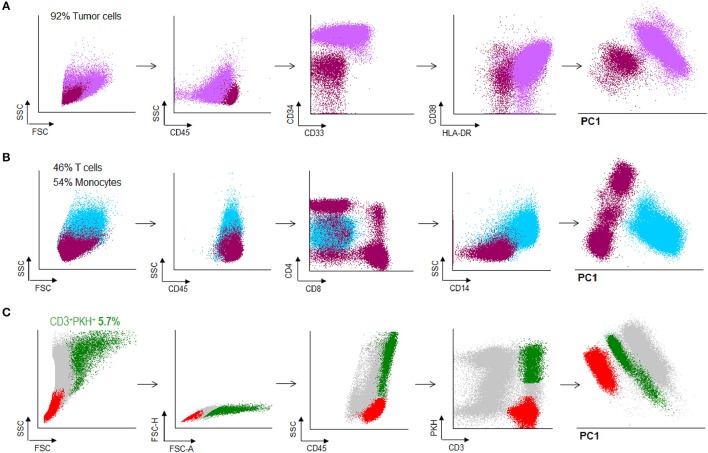
Doublet-forming T cells from peripheral blood of AML patients. (A) Blast cells from bone marrow of an AML patient were obtained and frozen. The immunophenotype of AML cells was: CD45low CD34++, CD38+, HLA-DR+ (purple population). (B) PBMC were obtained from peripheral blood when the patient was in CR and analyzed by flow cytometry. T cells represented the 46% of the total PMBC. (dark pink population) (C) T cells from the patient were co-incubated with AML cells. Doublet-forming T cells were identified based on their FSC/SSC characteristics, doublet zone FSC-A/FSC-H as well as their positivity for CD45 and both PKH and CD3 (CD3+PKH+; green population). Non-doublet T cells were also isolated to use them as control (CD3+PKH–; red population); one representative case is shown.